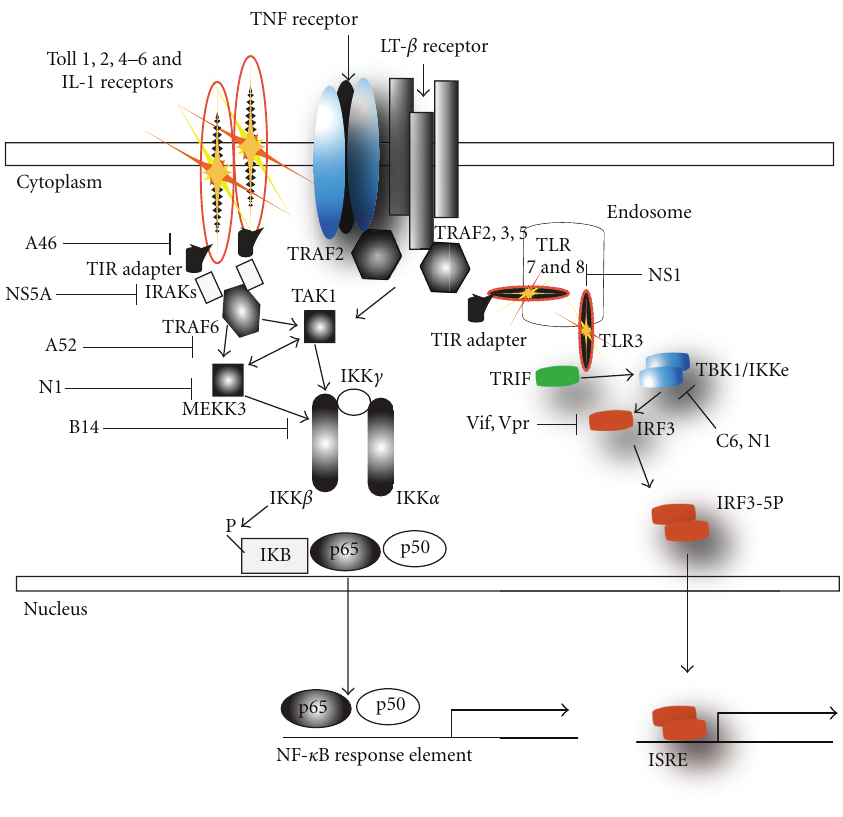
Figure 1: Signaling by the innate immune system that is inhibited by several viral proteins. This model depicts the salient features of TLR-induced NF- κ B and IRF3 induction. Several poxviral proteins N1, C6, A14 A46, and A52 inhibit the activation of NF- κ B and/or IRF3 signaling pathways, by interacting with and inhibiting the activity of the classical IKK complex (IKK α / β / γ ) as well as the nonclassical IKK ε /TBK1 complex. HCV protein NS5A inhibits TIR signaling by MyD88, its NS3/4A digests MAVS to inhibit RLR signaling, and its core protein inhibits Jak/Stat signaling. Finally, HIV Vif and Vpr degrade